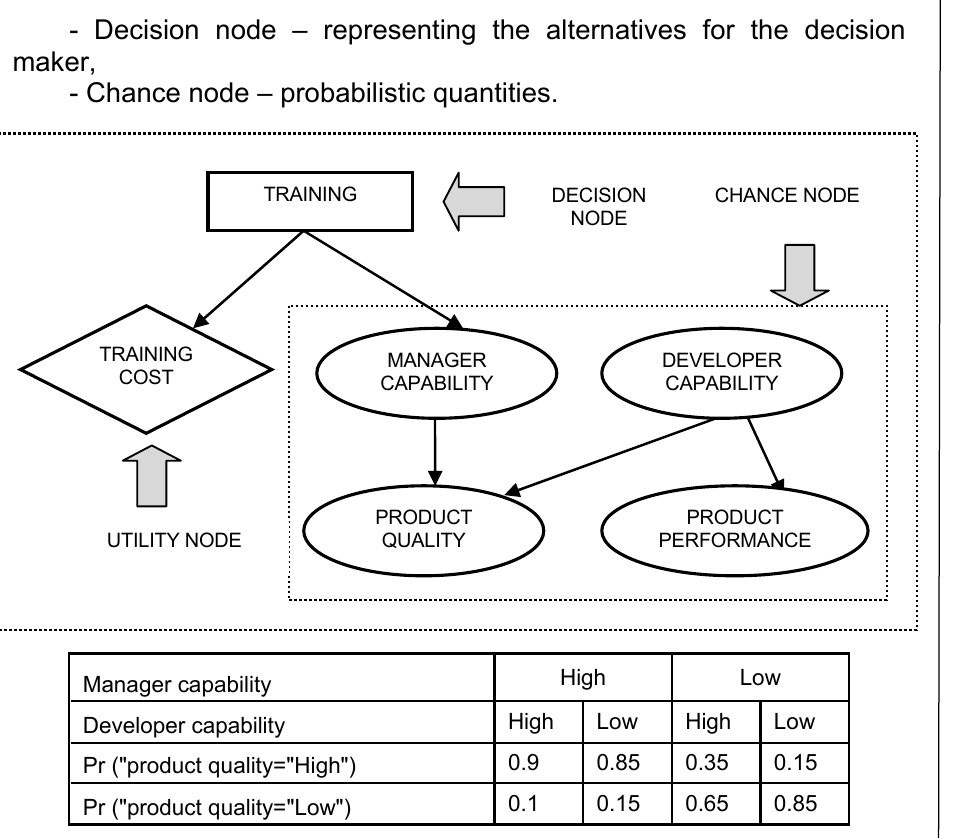
Figure 1 – Example of a Bayesian Decision Network – BDN Рис . 1 – Пример динамической байесовской сети Слика 1 – Пример динамичке Бајесове